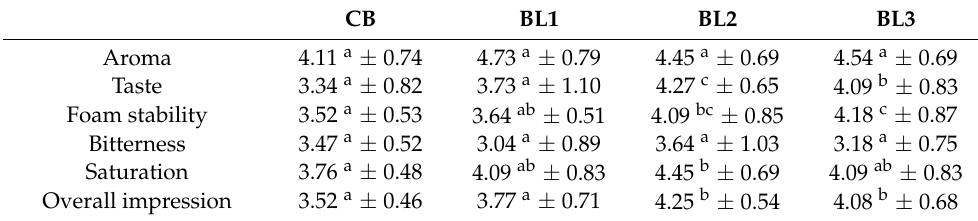
Table 4. Sensory analysis of wheat beers fortified with lemongrass